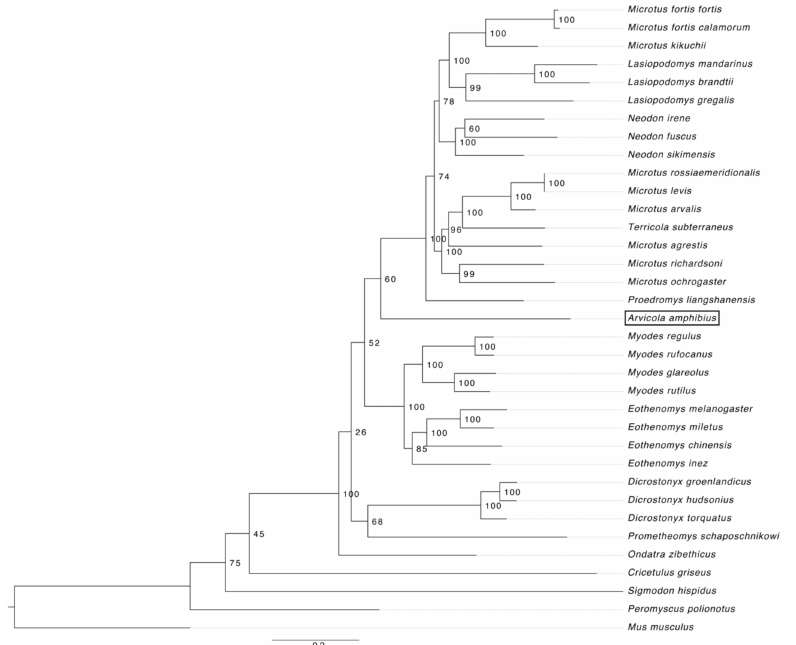
Figure 1. The maximum-likelihood (ML) phylogenetic tree of all available Arvicolinae species based on 13 protein-coding mitochondrial genes, rooted on the outgroup taxon Mus musculus